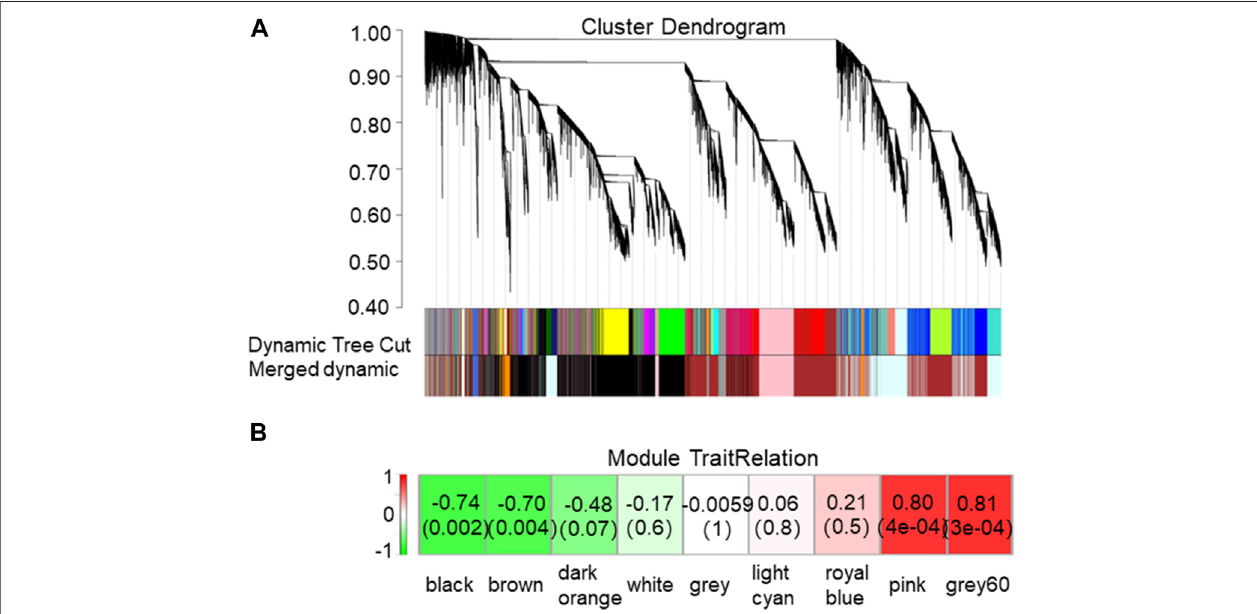
FIGURE 3 | Network analysis dendrogram showing modules identi fi ed by weighted gene co-expression network analysis (WGCNA). (A) Nine modules, each associatedwithaleafinthetreecorresponds toanindividualgene. (B) Associationbetweenmodulesand traits.Thecolorofeachmoduleisthesame asthatin (A) .The left column represents the color scale for module/feature dependencies from -1 to 1. Each cell in the right row contains the corresponding number of correlations and p -values. The bottom line represents the module name corresponding to the cell